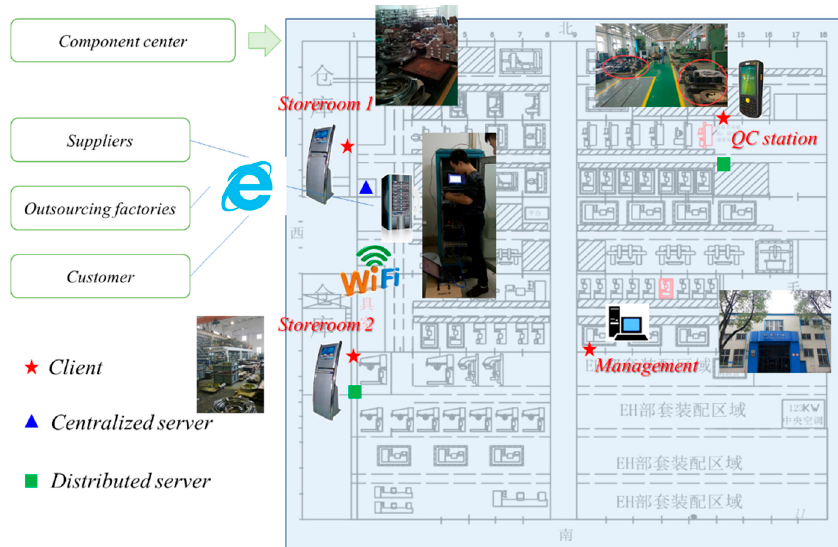
Figure 7. The production process of Component T in the industry chain.